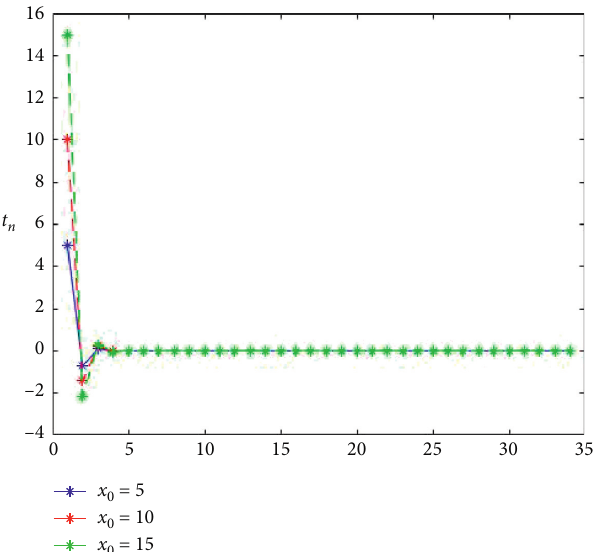
Figure 2: The convergence graph of the sequence t � 5, x � 10, and x values x 0 0